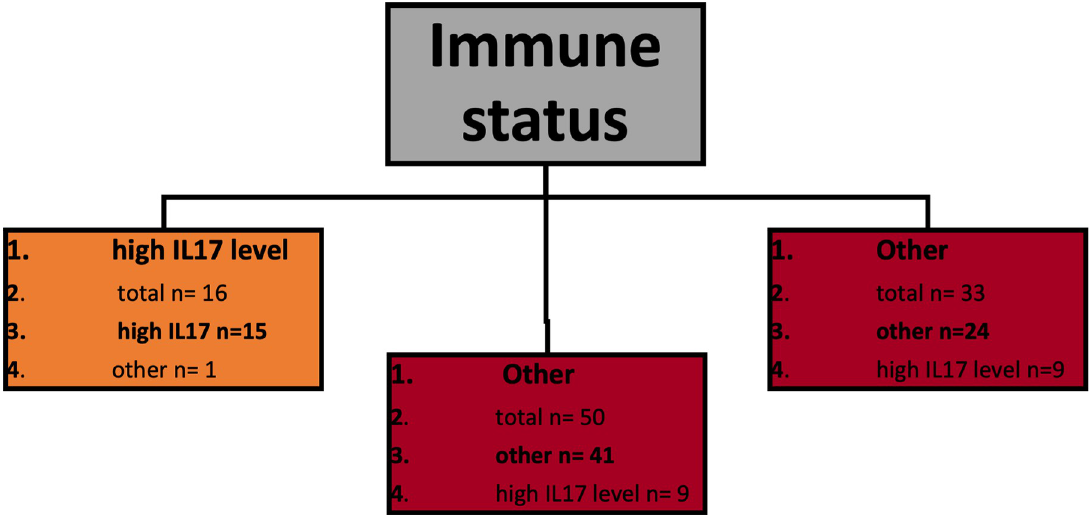
Fig 3. Classification model of high urine interleukin levels. This model classifies two separate labels: high IL17 level vs. other . In the opposite to Fig 2, in this model, labels high IL1 β and high IL6 level have been consolided into one label other . Each of the leaves contains the following information: point 1 –dominating label presented in bold, point 2- n- total number of observations classified in this leaf, points 3–5: the numbers of each observations classified in this leaf including the dominating one.